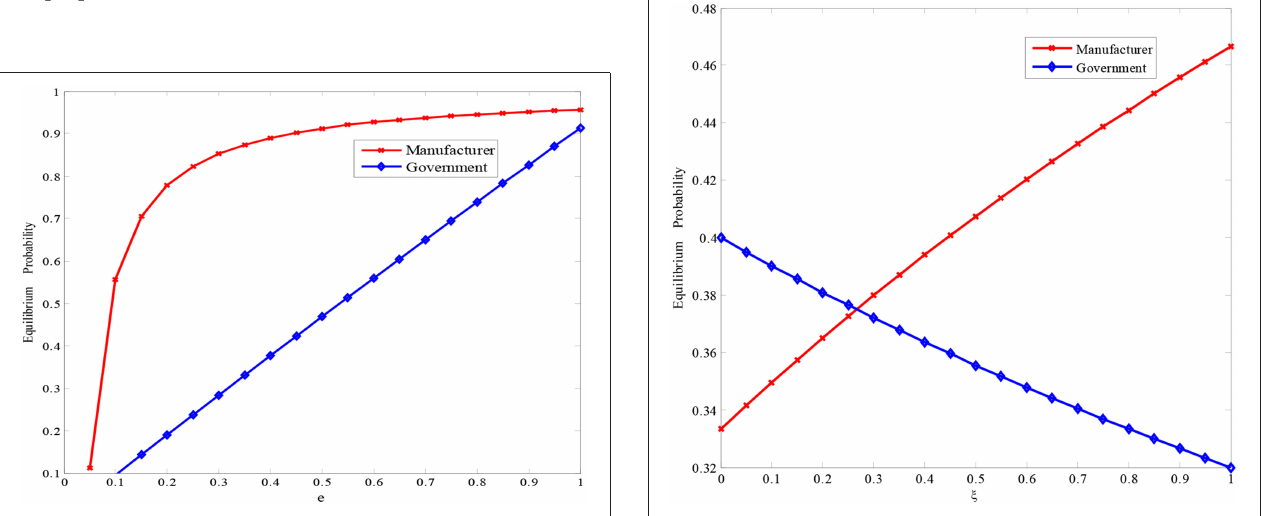
FIGURE 3 | Game members’ equilibrium probabilities as a function of e .